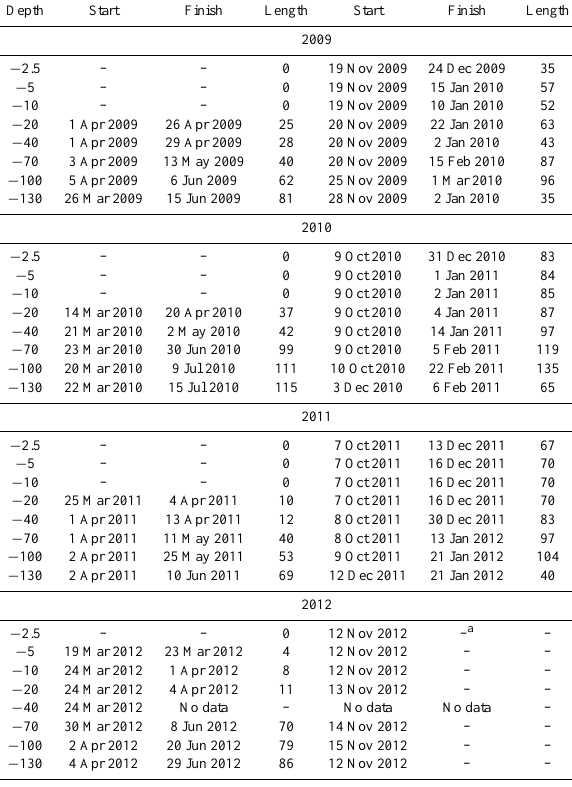
Table 4. Dates (day/month/year) of starting and finishing of the main zero curtain period during the early finish freezing thermal season, and their length in days ( a period still not finished at 22 January 2013). Depth